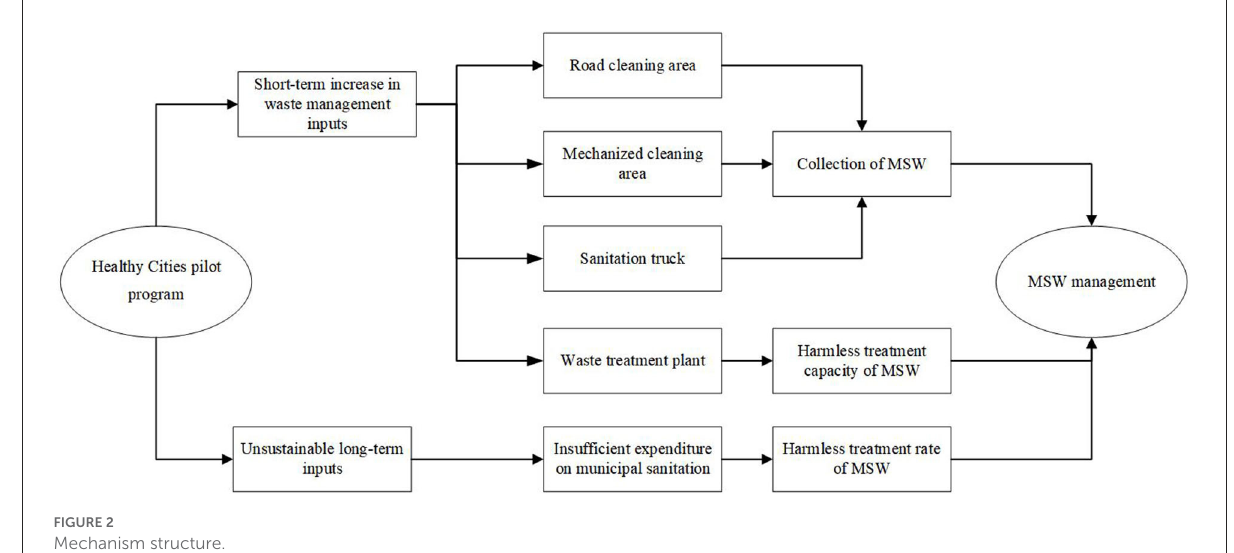
FIGURE2 Mechanism